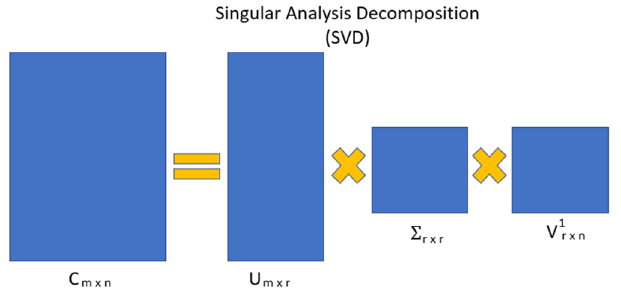
Figure 5. Singular value decomposition process for feature dimension reduction.